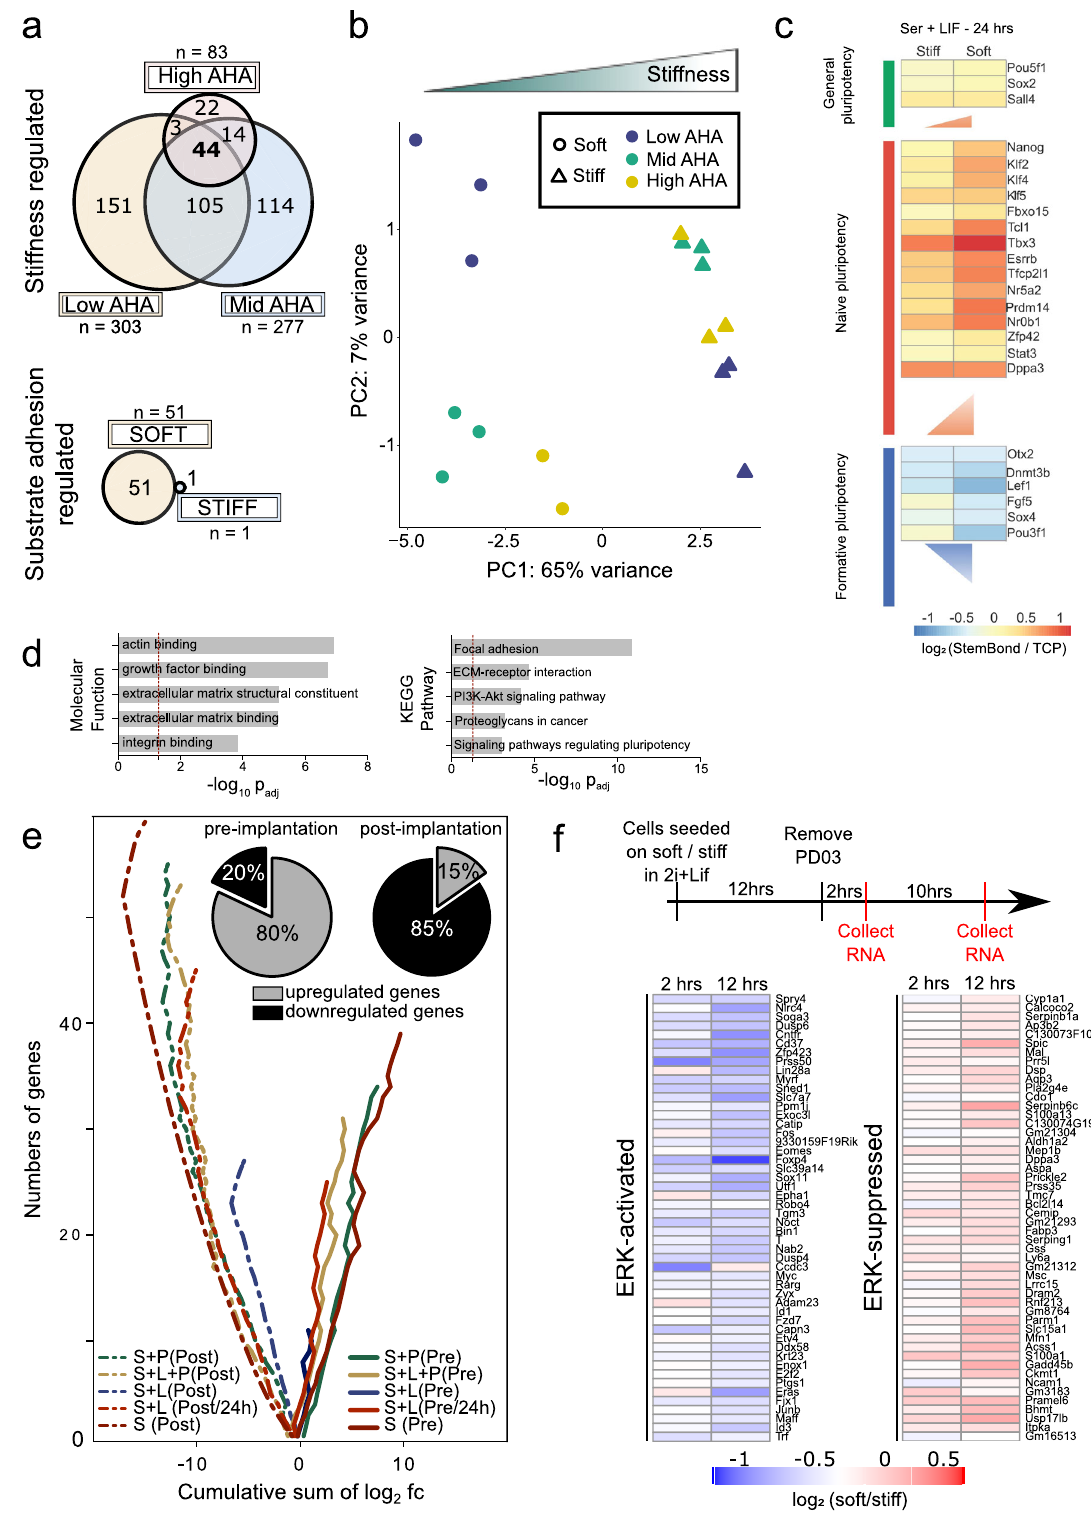
interactions between substrate stiffness and the LIF/STAT3 and MEK/ERK pathways, which respectively drive naïve self-renewal 18 and early differentiation 42,43 . Gene ontology analysis on the genes differentially regulated by substrate stiffness (in serum ± LIF ± PD03) showed that beyond